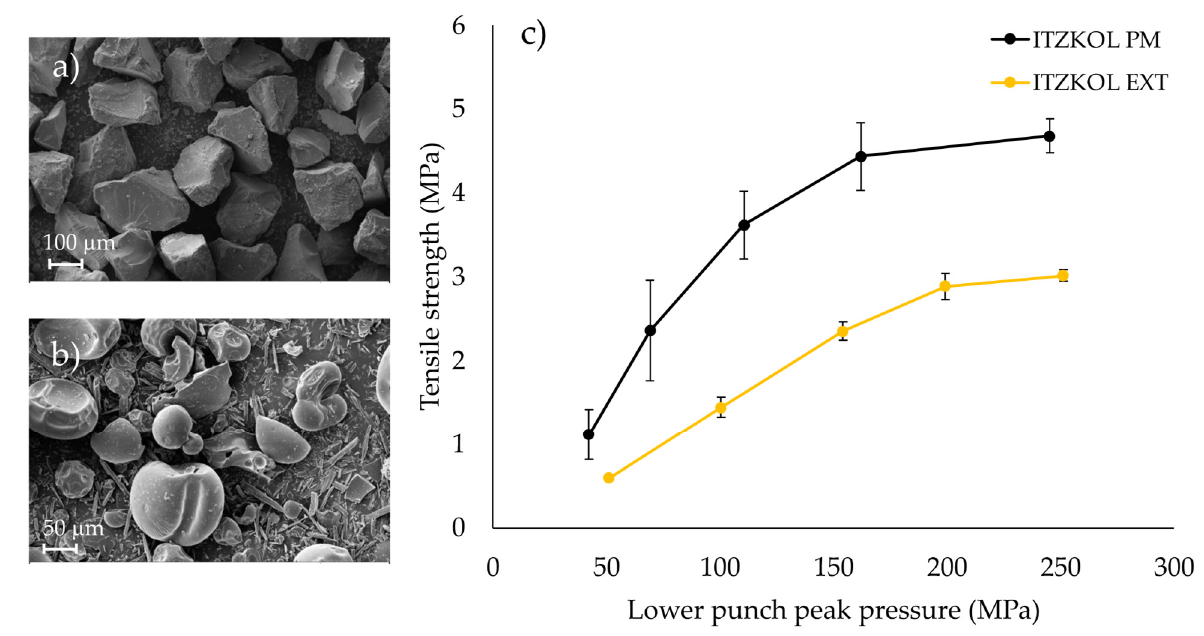
Figure 5. SEM pictures of ( a ) ITZ-KOL-ASD amorphous solid dispersion, ( b ) ITZ-KOL-PM physical mixture and ( c ) tabletability plots of respective ITZ-KOL-PM and ITZ-KOL-ASD tablets ( n = 10).